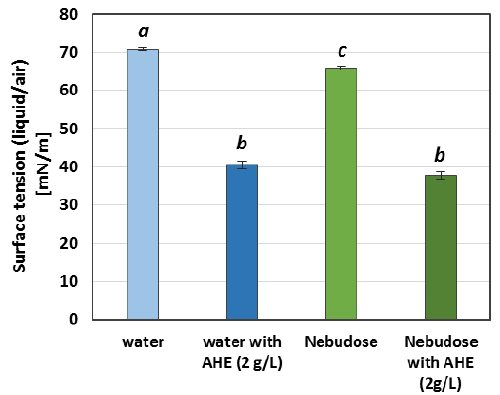
Figure 1. The surface tension of the emulsion components. Small, italicized letters in the same column indicate the statistical similarities and differences between the data series ( p < 0.05).